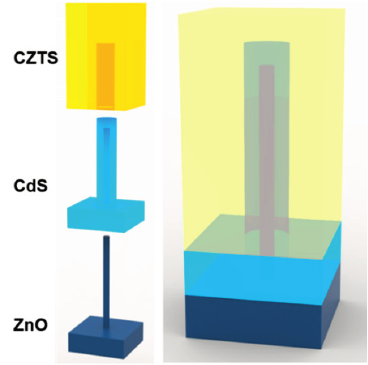
Figure 7. Model of the proposed nanowire-nanofilm unit cell